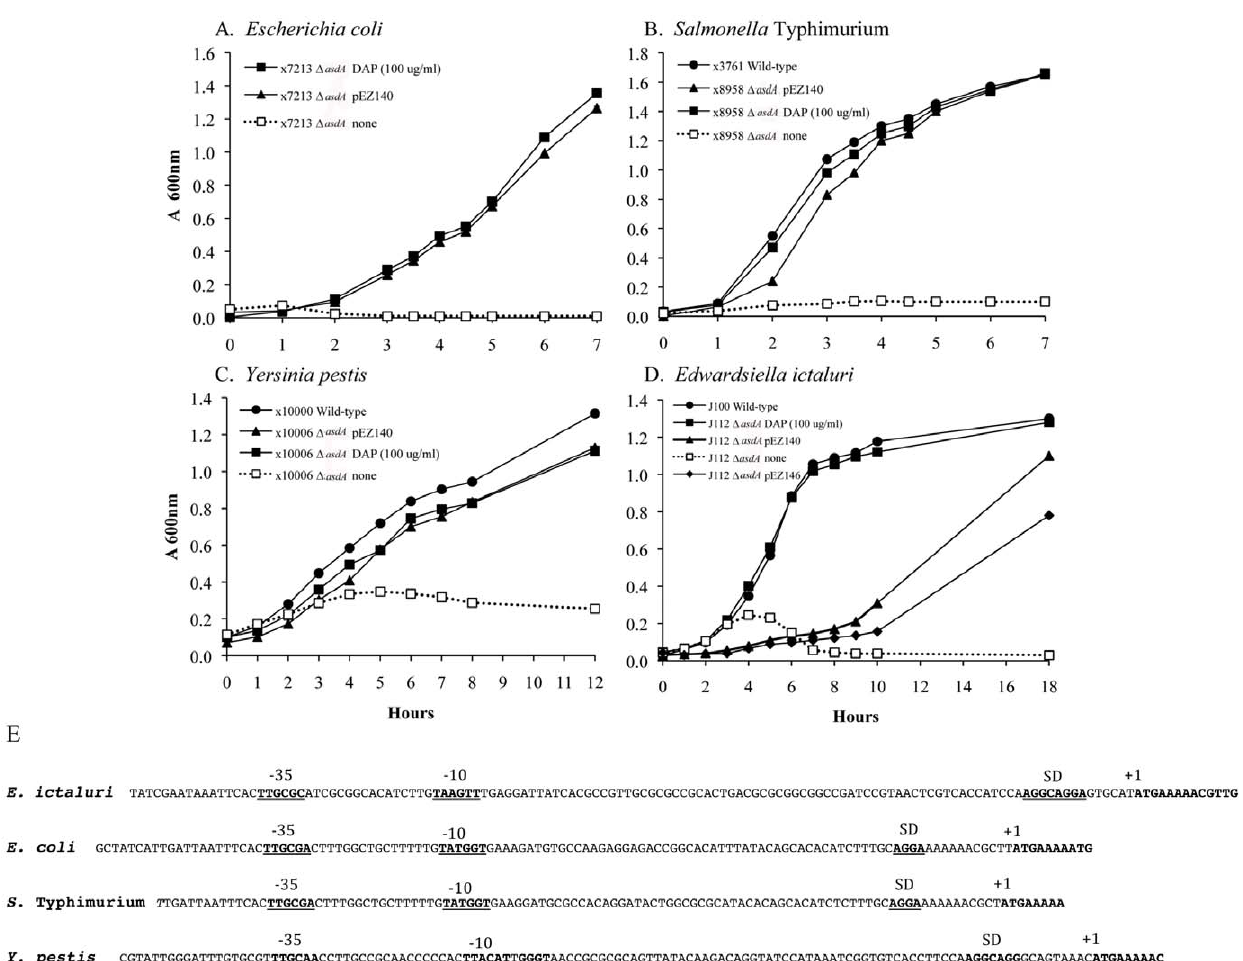
Figure 5. Complementation of representative D asdA mutant strains with E.ictaluriasdA gene. ( A–D ) Growth of representative D asdA mutant strains complemented with asdA from E. ictaluri. pEZ140 (SD- asdA ); pEZ142 (P asdA - asdA ); The strains were grown in BHI at 28 u C with agitation (180 r.p.m.); ( E ) Promoter region of asdA gene from E. ictaluri and representative strains.